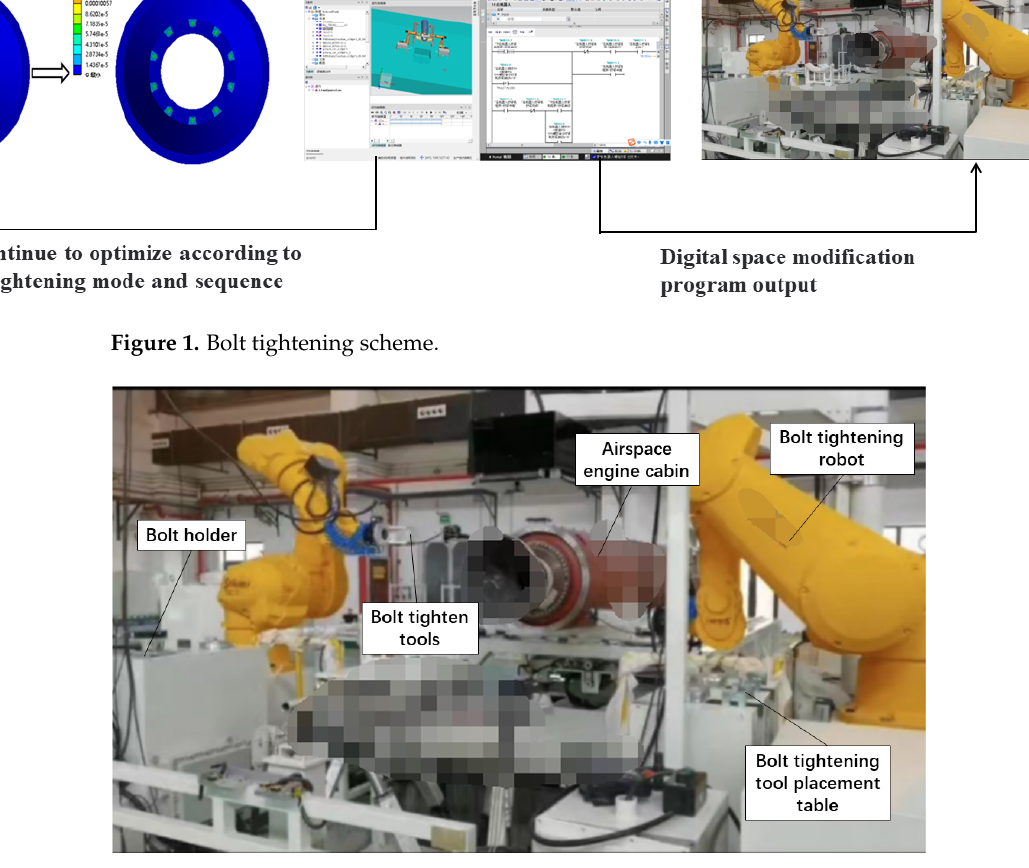
Figure 2. Bolt tightening